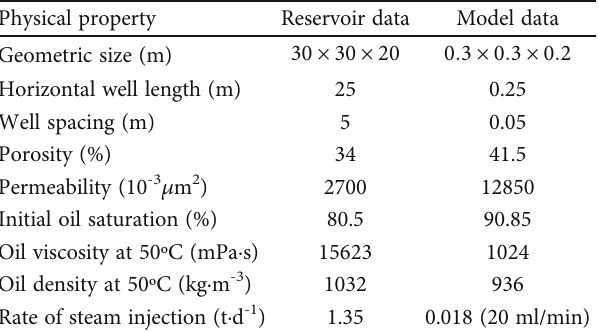
Table 1: Fluid parameters of the reservoir and model